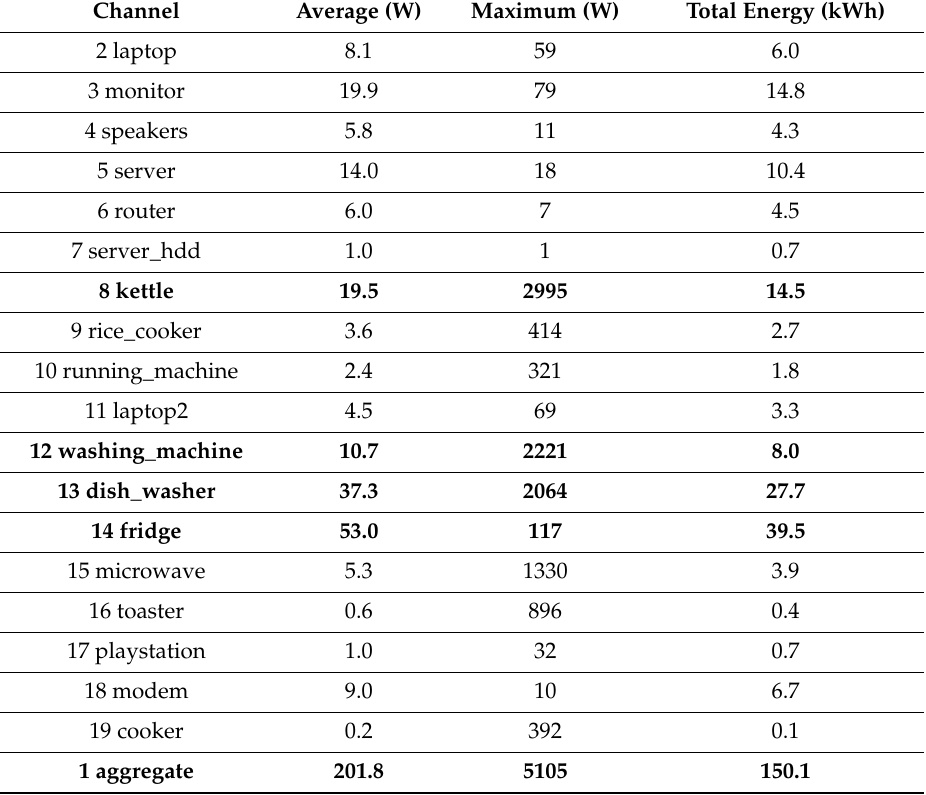
Table 2. Summary of appliances in UK-domestic appliance-level electricity (DALE) house 2 during July 2013.